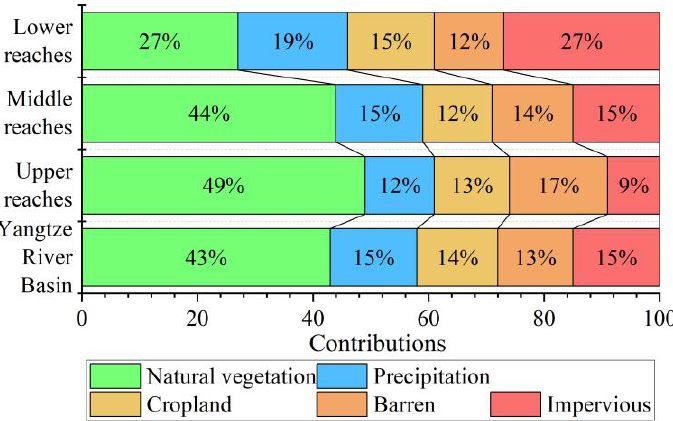
Figure 15. Contributions of impacts of explanatory factors on spatial turbidity variations of Yangtze River basin and different reaches using the random forest regression analysis.